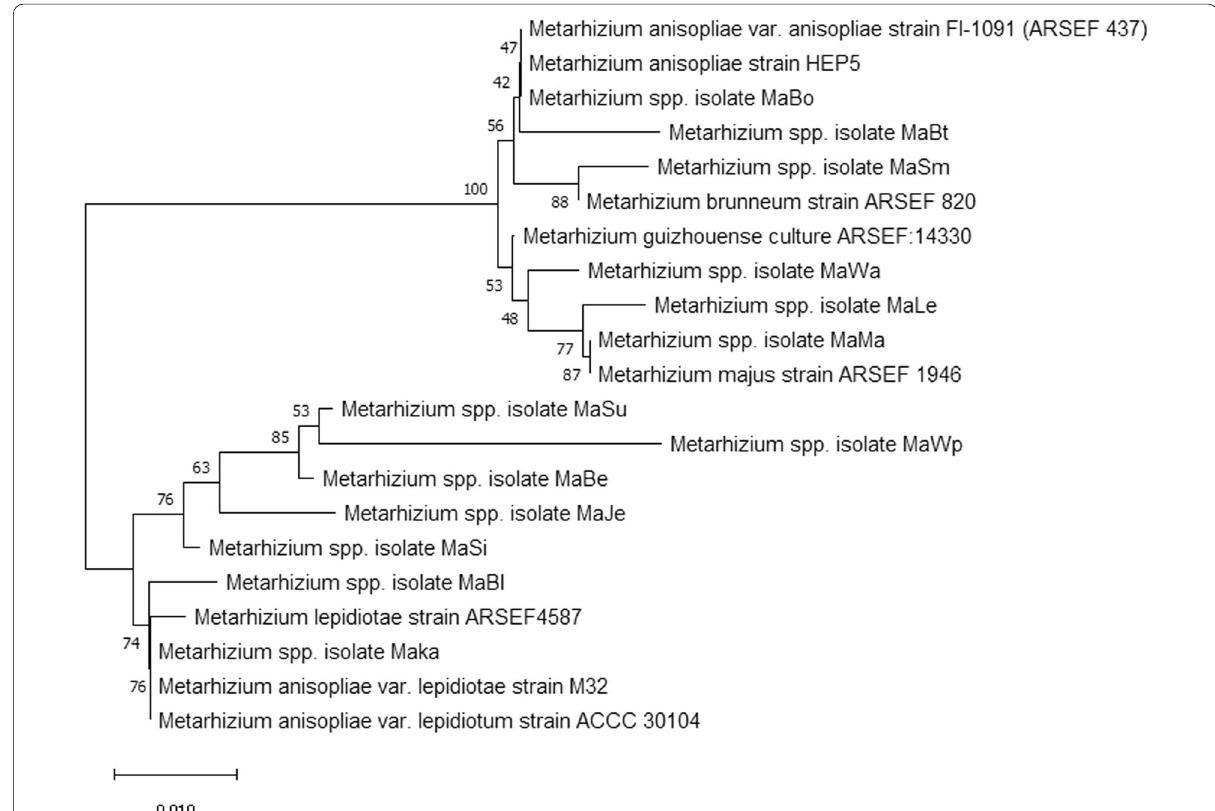
Fig. 4 Neighbor joining phylogenetic tree based on ITS-5.8S rDNA gene sequencing of 13 Metarhizium isolates. The strains Metarhizium in the phylogram were obtained from